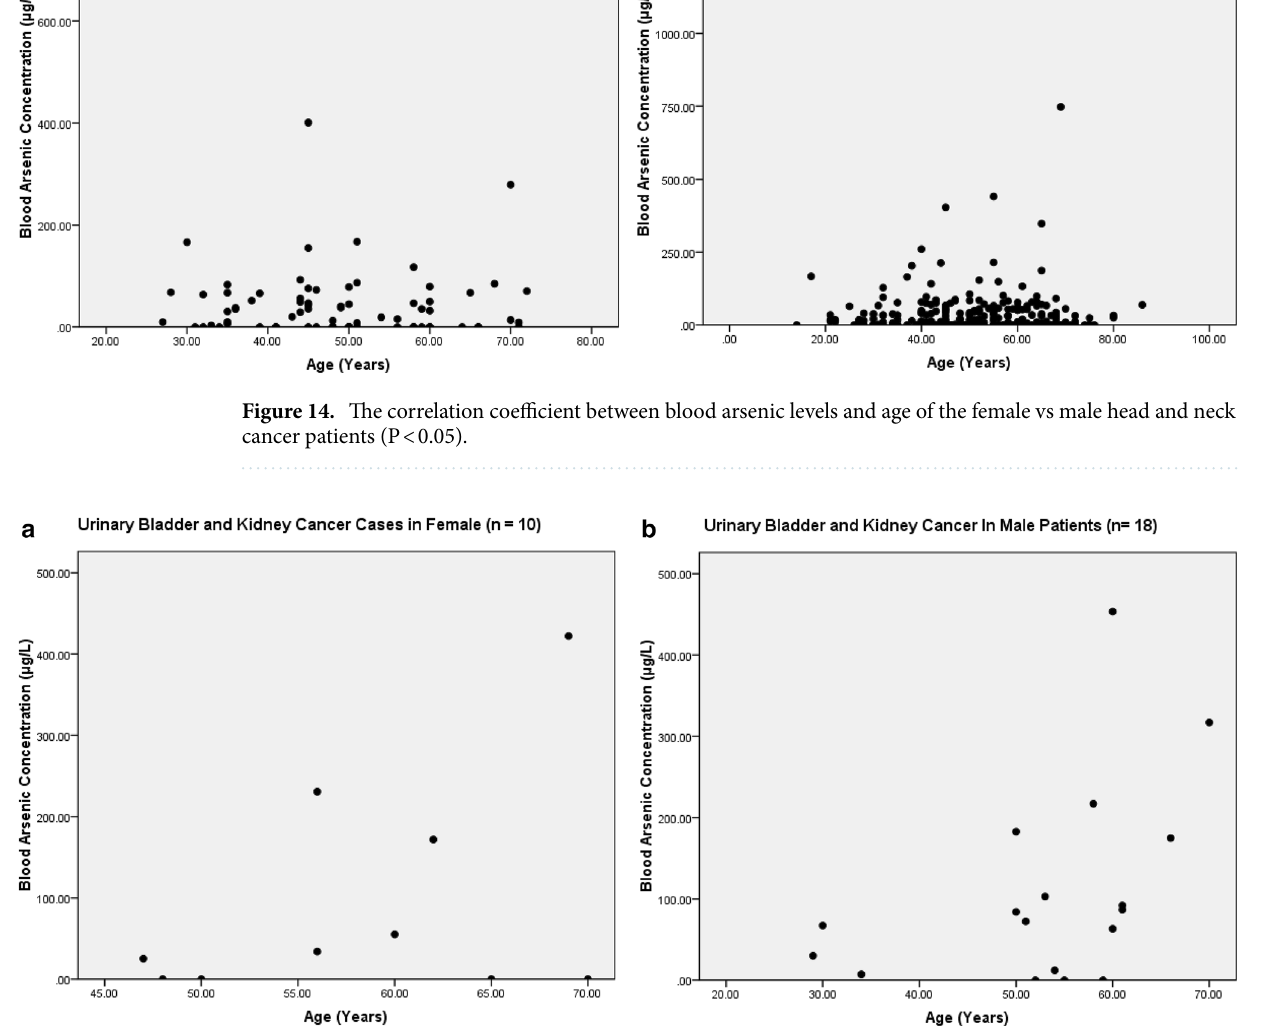
Figure 15. The correlation coefficient between blood arsenic levels and age of the female vs male urinary bladder and kidney cancer patients (P <